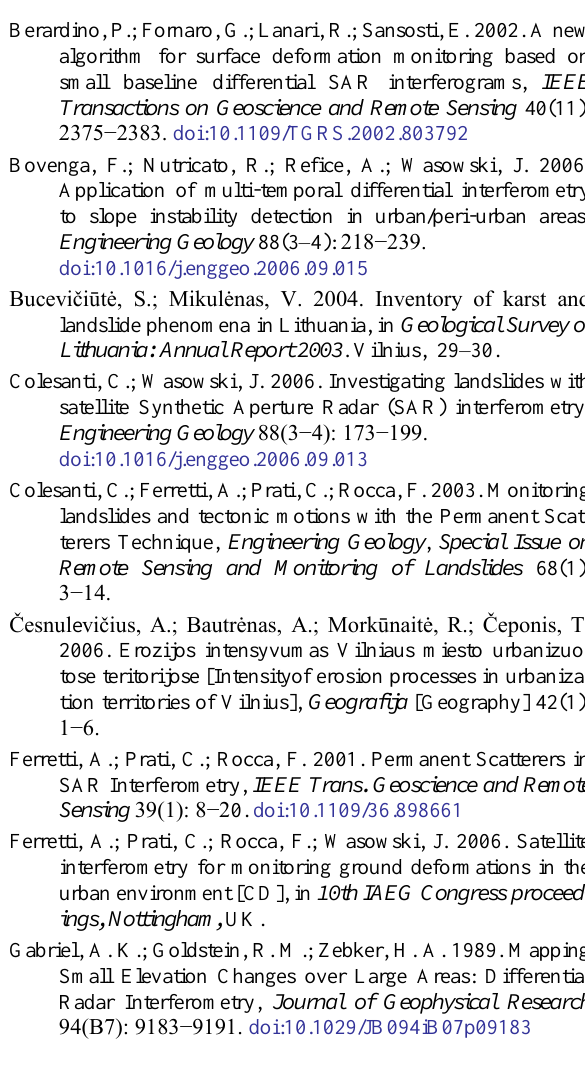
Fig. 7. PS with negative velocities below – 2 mm/yr (red) and stable points between – 2 mm/yr and +2 mm/yr (green) in the Lazdynėliai area, superimposed on the background of geological map at the scale 1: 50 000 (Guobytė 1996). Note that most PS in the area of lacustrine deposits (blue colour) show negative